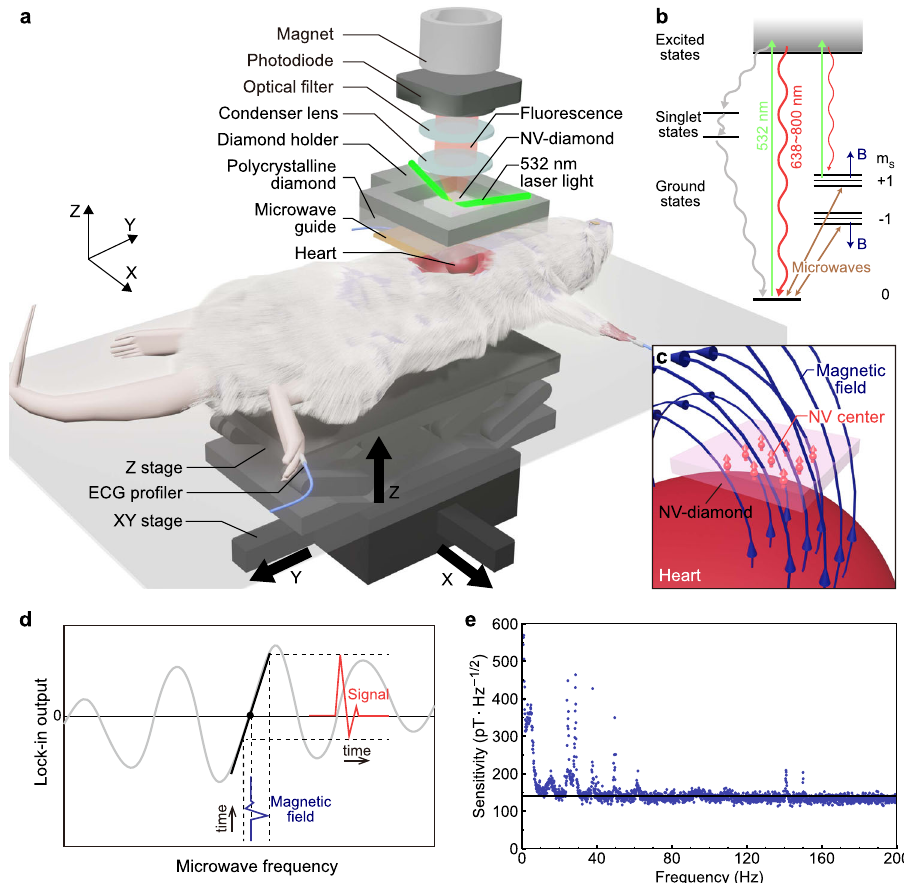
Fig. 1 Magnetocardiography based on a solid-state quantum sensor. a Schematicof the rat magnetocardiography (MCG) setup. A living rat ’ s heart remains approximately one millimetre below a diamond chip containing an ensemble of nitrogen-vacancy (NV) centres. The rat is scanned automatically along the XY- axes for magnetic fi eld mapping and manually along the Z-axis for height adjustment. An electrocardiography (ECG) signal is monitored through ECG pro fi lers concurrently with the MCG. The NV centres are excited by a 2.0 W green laser light. This excitation entails spin-state-dependent fl uorescence collected by an asphericcondenser lens. b NVcentreenergyleveldiagram.The m S = ±1groundstates are split bya biasmagnetic fi eld and mixed bymicrowavesresonant with the NV transition frequencies. Each of the ground states are further split by hyper fi ne interactions with the host 14 N nuclear spin. c Enlarged view of the heart and diamond. Electric currents fl owing through the heart generate a circulating fi eld (blue arrows). The NV centres (red arrows) along the [111] orientation are sensitive to the Z-component of the magnetic fi eld. d Magnetometry principle. The time-varying cardiac magnetic fi eld (blue), which shifts the NV transition frequency, is converted to a change in the lock-in-demodulated fl uorescence signal (red). Five peaks are observed in the lock-in optically detected magnetic resonance (ODMR) spectrum because three hyper fi ne transition frequencies are excited with three-tone microwaves. e Magnetic fi eld sensitivity across the rat ’ s heart signal frequency band of DC ~200Hz. The black dashed line indicates 140 pTHz − 1/2